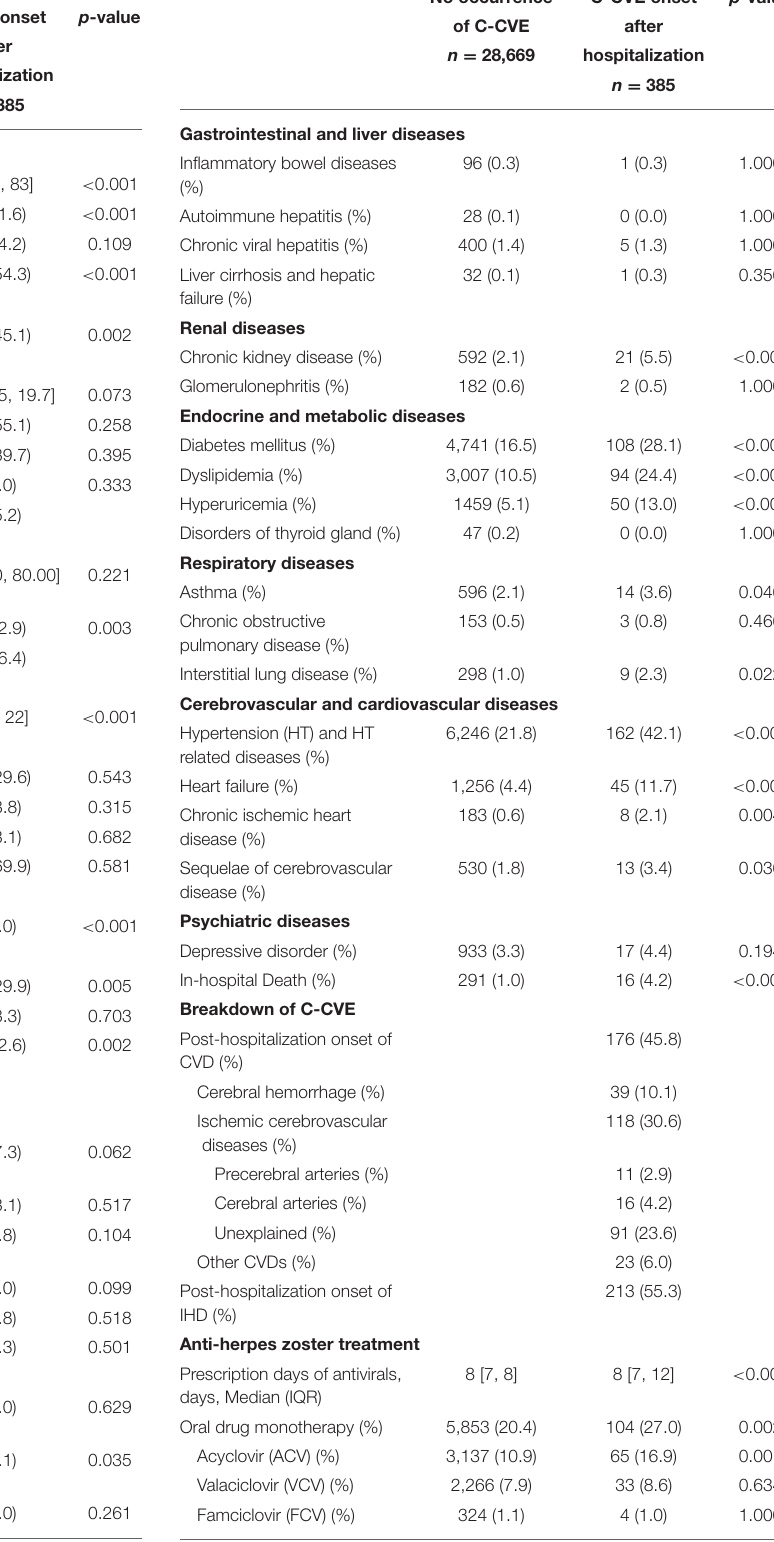
TABLE 3 | Baseline clinical characteristics between C-CVE onset cases and no occurrence of C-CVE